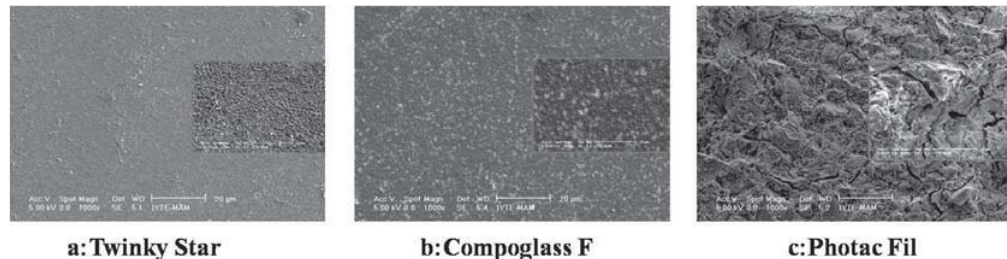
Figure 4- SEM micrographs of the specimens after NNaF gel application